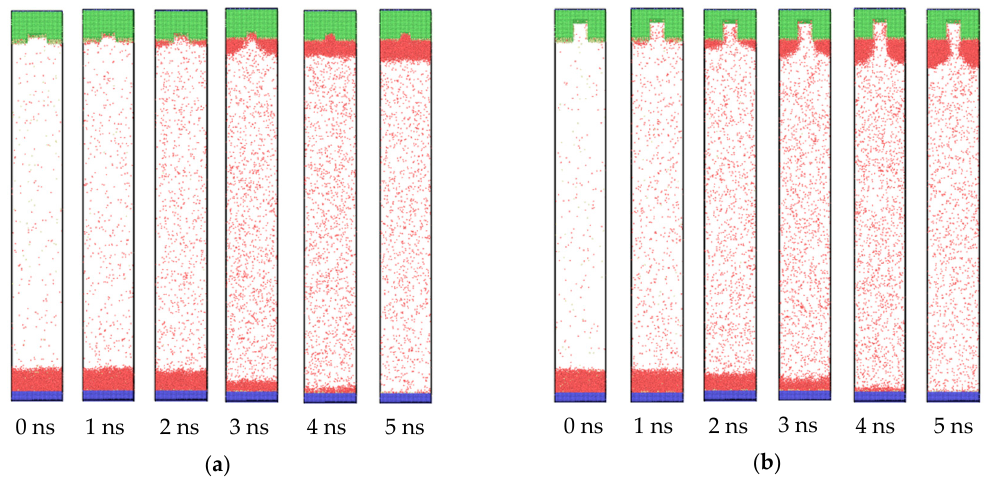
Figure 7. Snapshots of the atom trajectories for nanostructures with a groove width of 2.4 nm and heights of ( a ) 0.8 and ( b ) 2.8 nm on hydrophobic surfaces.